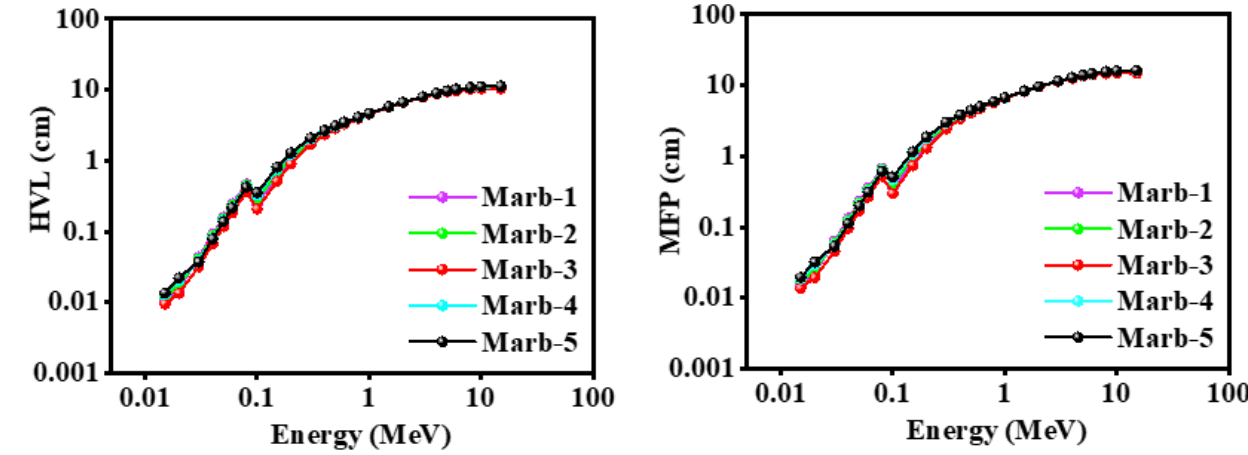
Figure 9. The theoretical value of the HVL and MFP of the prepared composites within the energy limit of 0.015 MeV to 15 MeV. limit of 0.015 MeV to 15 MeV.